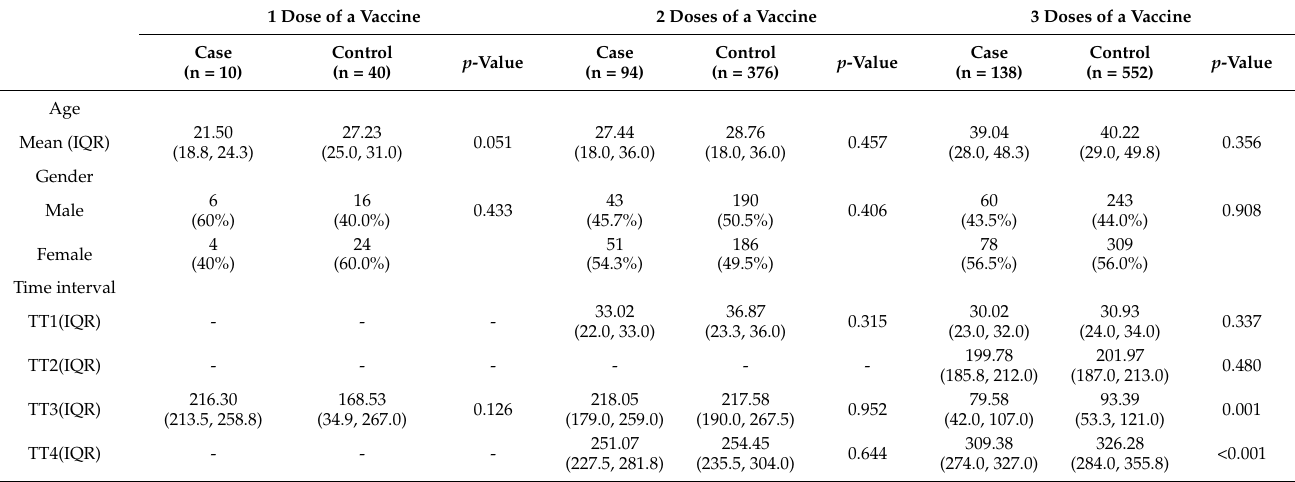
Table 2. Demographic characteristics of cases and controls vaccinated with different doses.